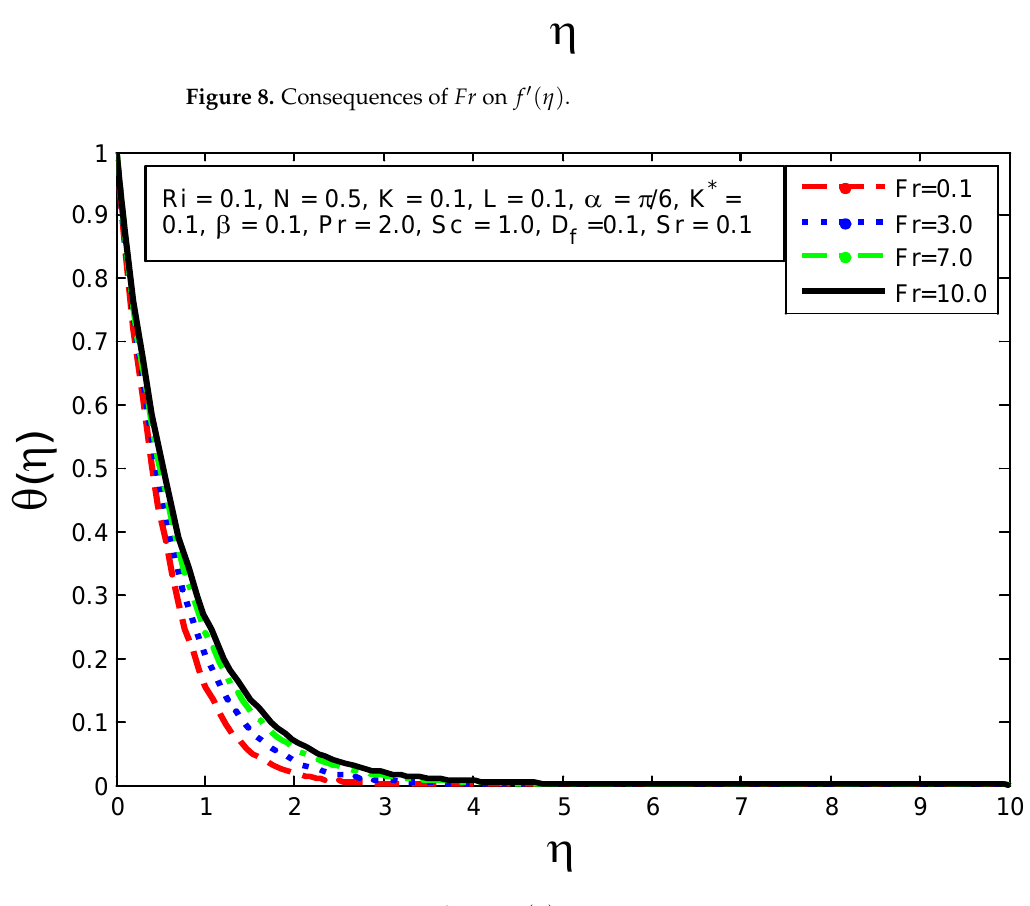
Figure 10. Consequences of 𝐹𝐹𝑆𝑆 on 𝜙𝜙 ( 𝜂𝜂 ) .